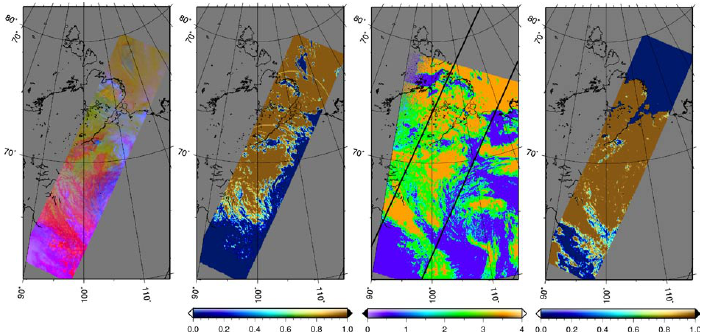
Figure 12. Northern part of Russia. AATSR: 22 April 2006, 04 h 43'20'', orbit number 21658. MODIS: 22 April 2006, 04 h 45'. Left panel is the false color composite (red is 11µm BT, green is 550nm reflectance, blue is 1.6µm reflectance) of initial AATSR scene; second left panel is the clear snow mask of AATSR scene (0 – not snow, 1 – clear snow) achieved with presented method; third left panel is MODIS cloud mask: 1 – cloudy, 2 – probably cloudy, 3 – probably clear, 4 – clear; right panel is operational AATSR cloud mask from level-1b product: 0 – cloudy, 1- clear.